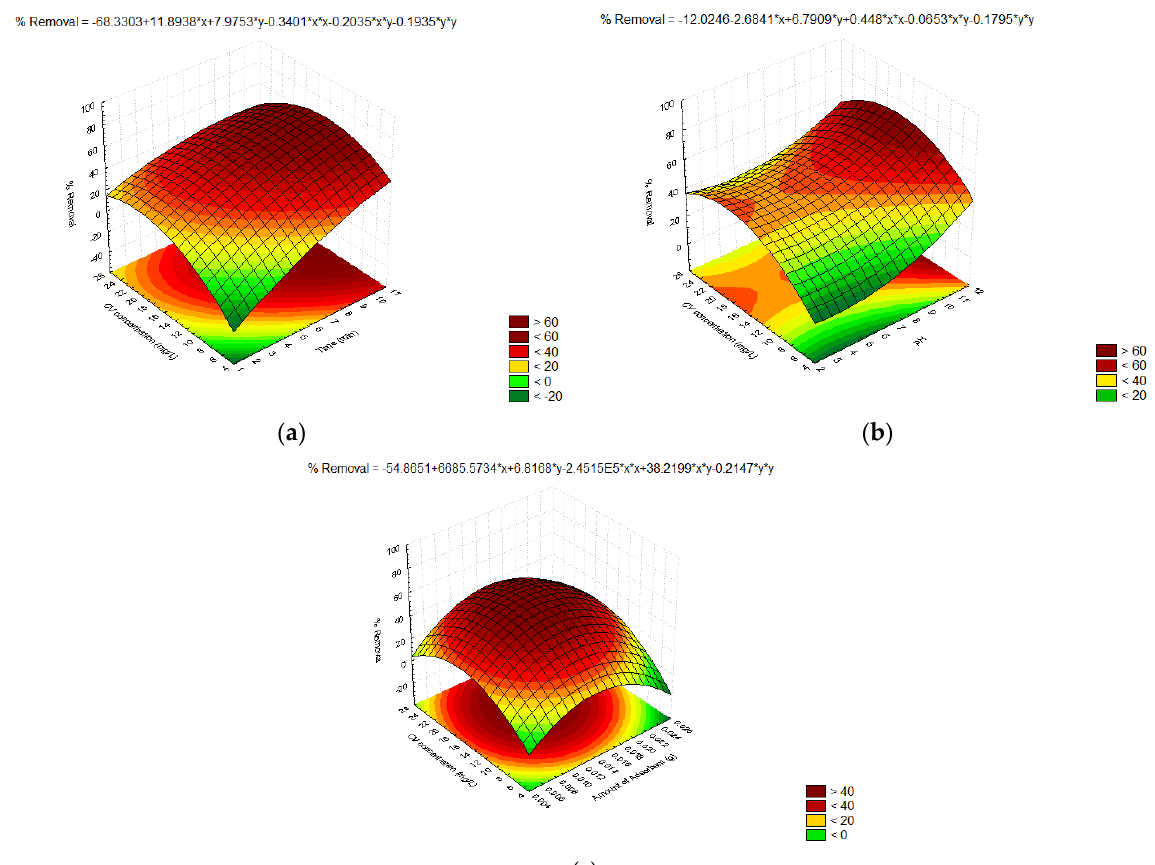
Figure 7. Three ‐ dimensional RSM plots for the adsorptive decontamination of CV by the IZNC as a function of ( a ) time and CV concentration, ( b ) pH and CV concentration, and ( c ) the amount of nanocomposites and CV concentration.